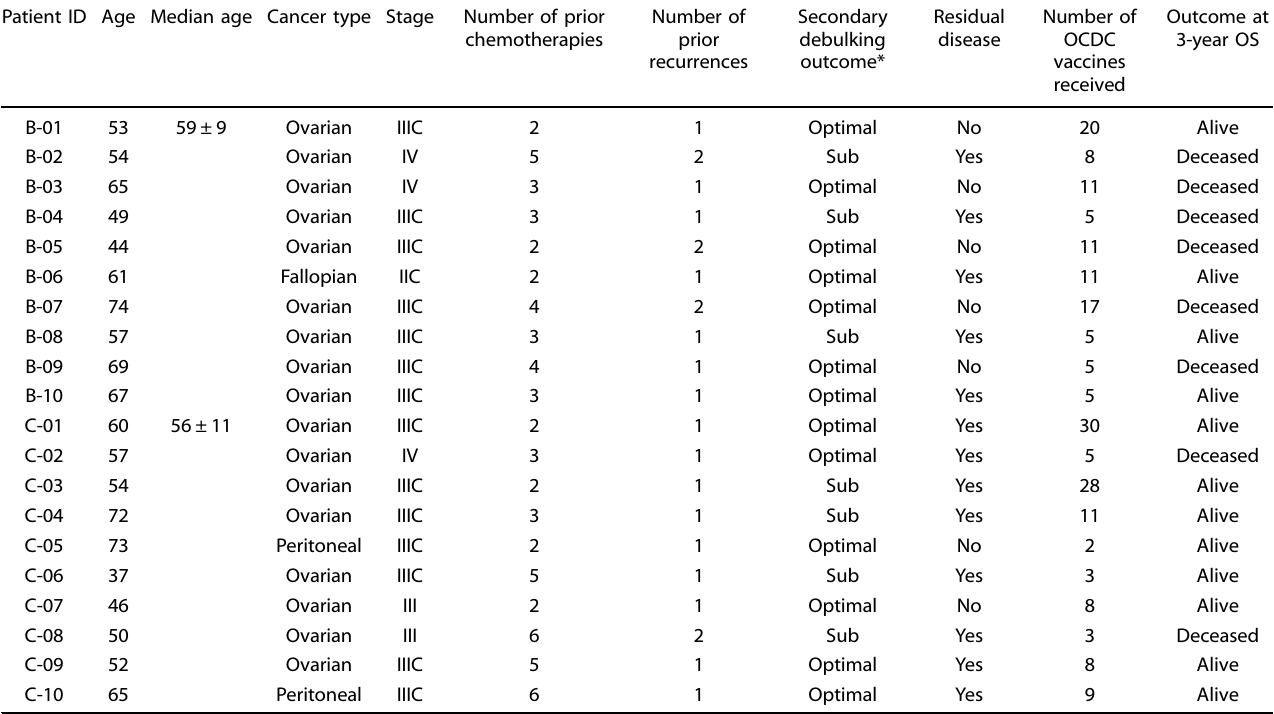
Table 1. Ovarian cancer (OC) patients ’ characteristics and treatment details. Patient ID Age Median age Cancer type